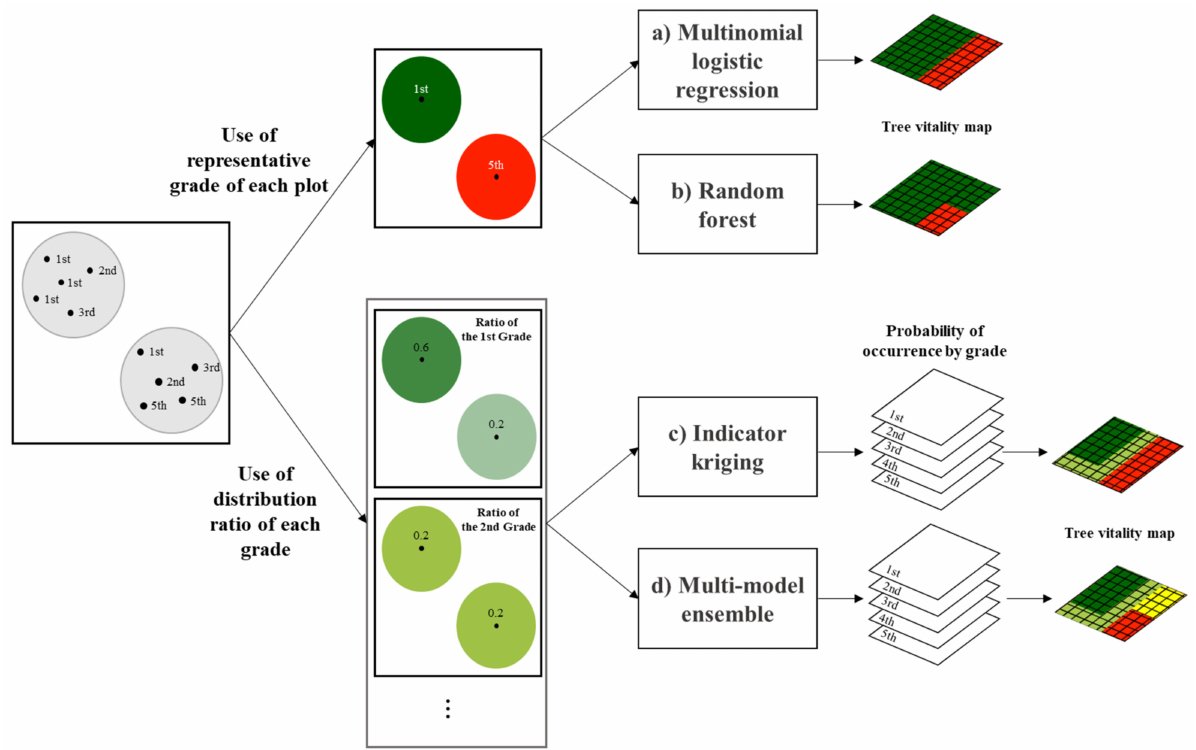
Figure 3. Classification scheme applied to the spatialization methods used in this